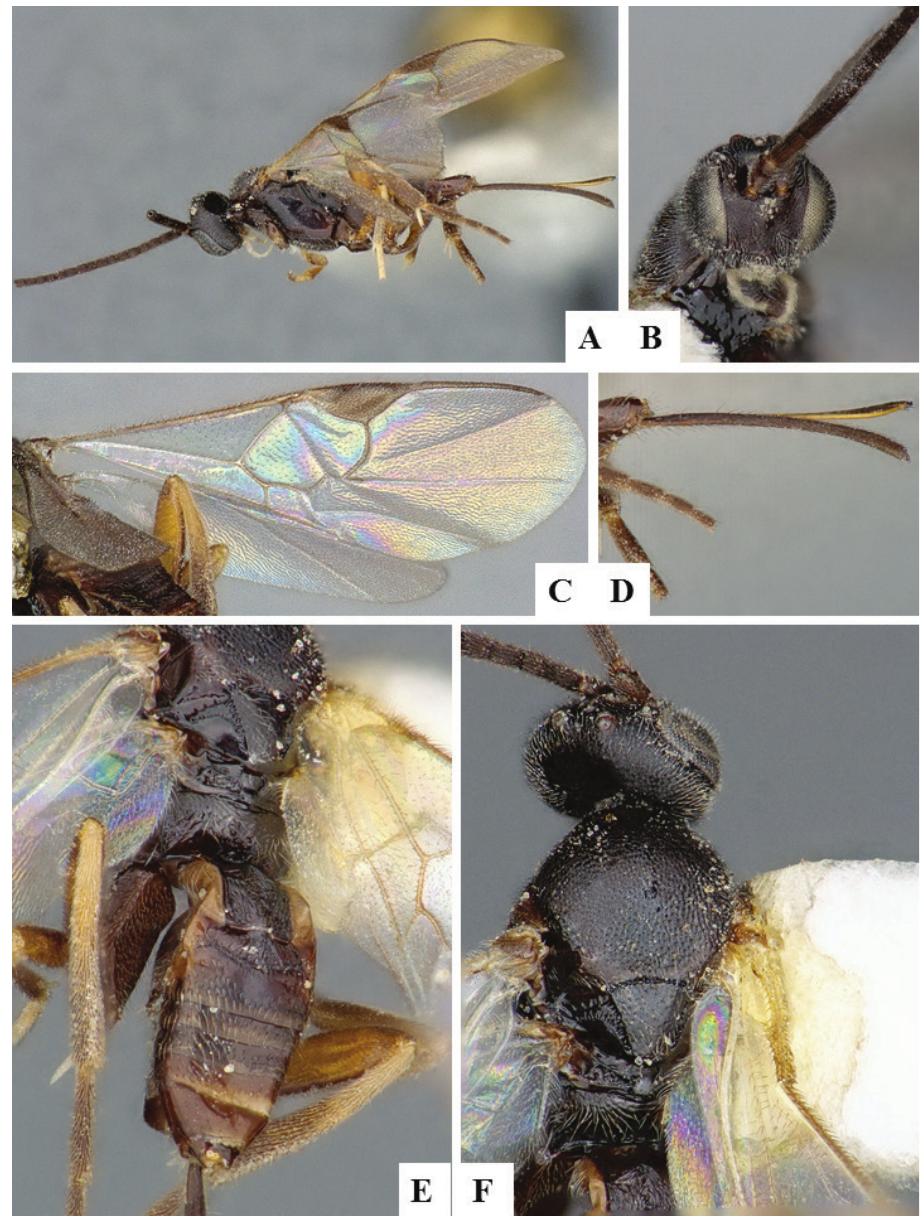
Figure 22. Dolichogenidea renaulti. A Habitus, lateral B Head, frontal C Wings D Ovipositor sheaths E Mesosoma (partially) and metasoma, dorsal F Head and mesosoma,